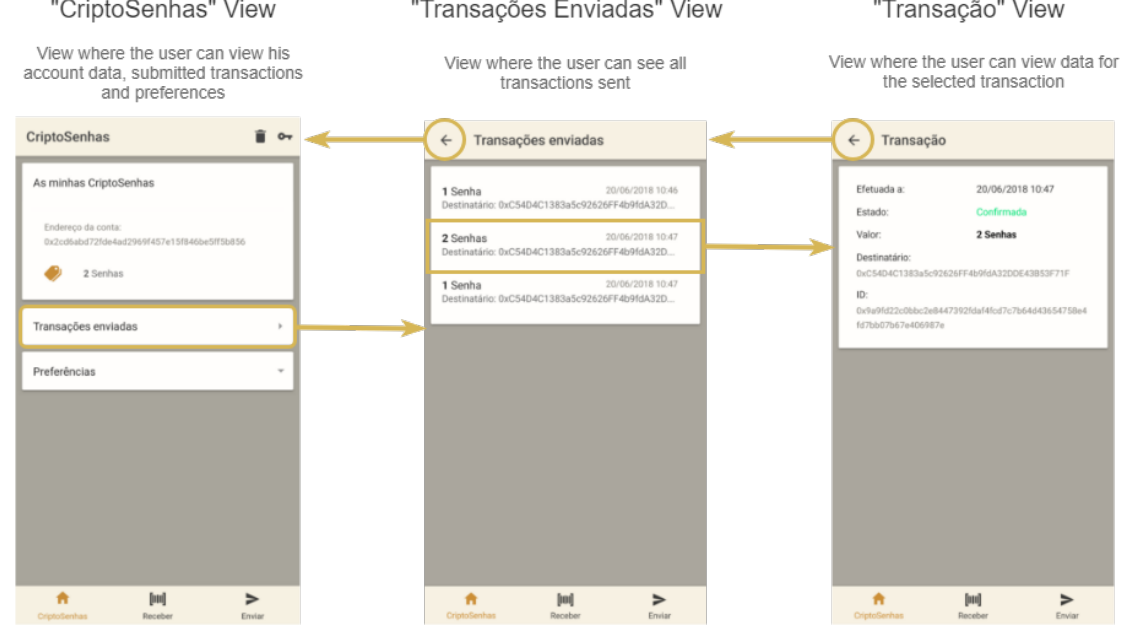
Figure 16. Navigation Diagram of the initial view “CriptoSenhas” and of the transactions sent.